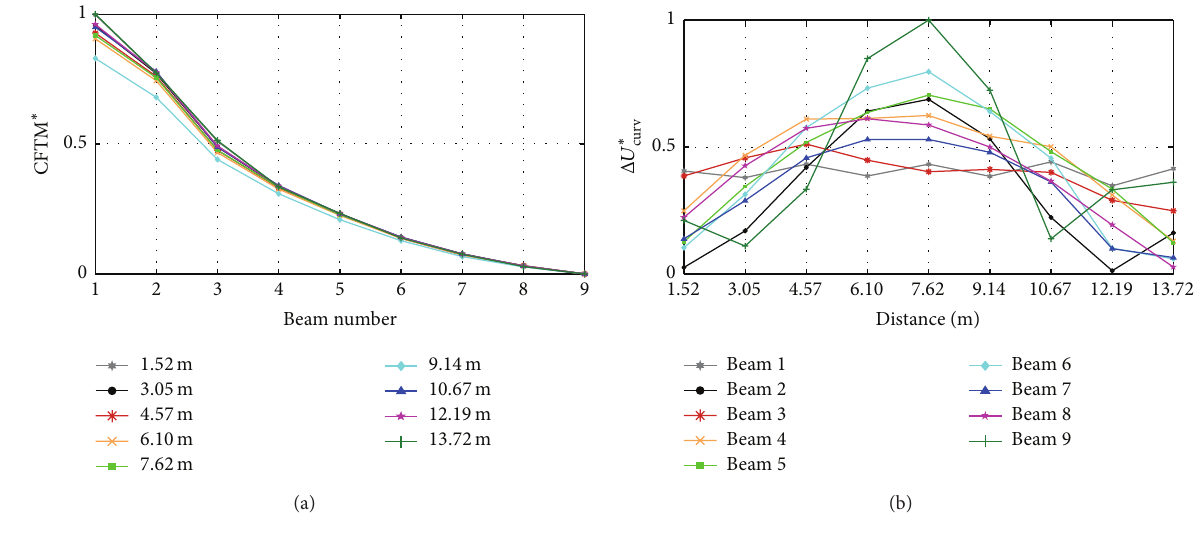
Figure 15: Plot of (a) CFTM ∗ and (b) Δ𝑈 ∗